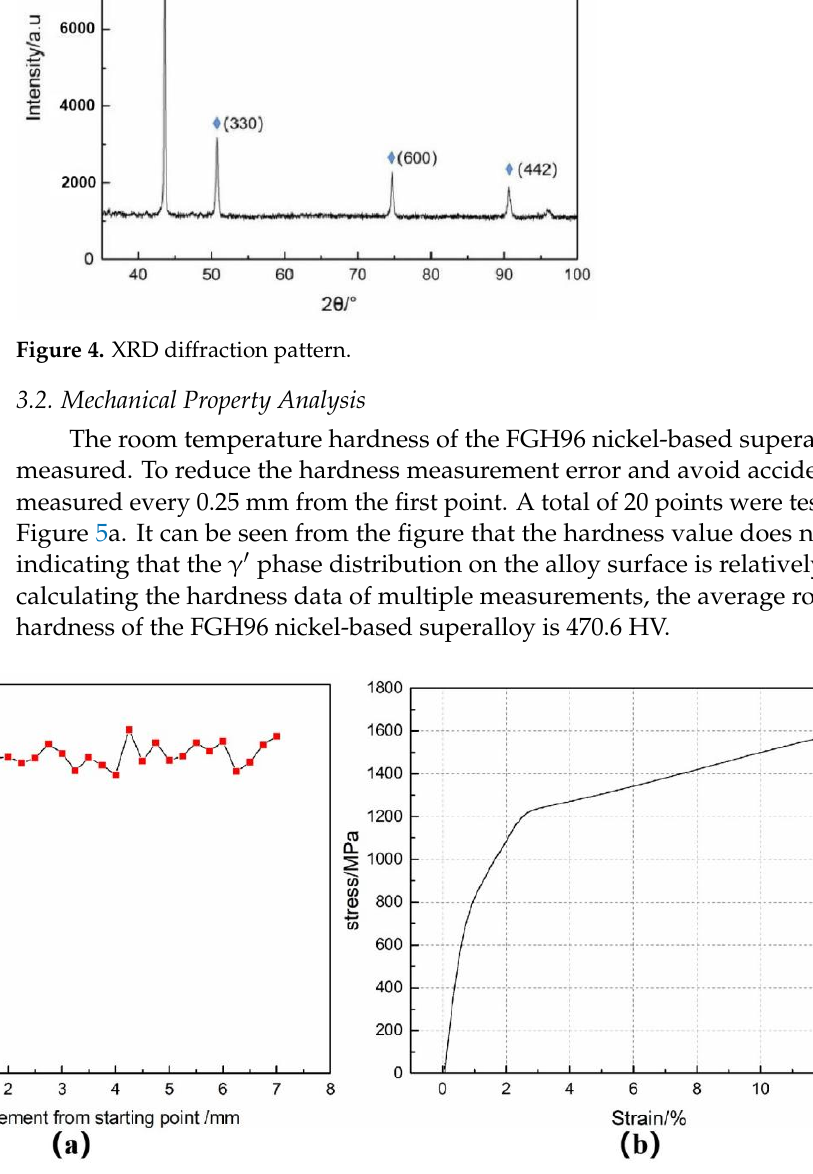
5 of 16 Figure 3. Microstructure of FGH96 alloy: ( a ) light microscope structure, ( b ) primary γ′ phase and